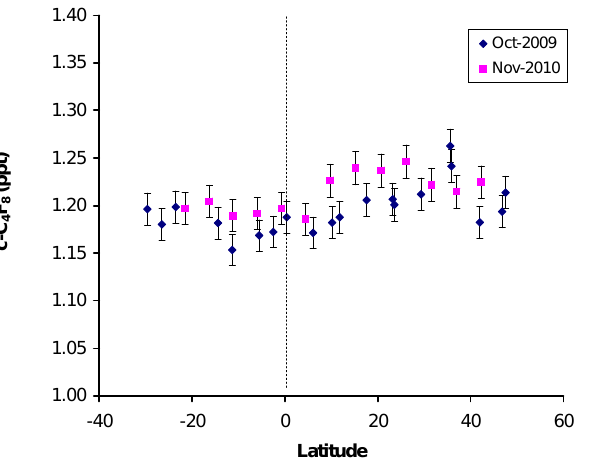
Fig. 4. Lower stratospheric measurements of c-C 4 F 8 from Geo- physica flights in the Northern Hemisphere between October 2009 and January 2010 plotted against mean age of air. y-axis error bars show the mean analytical precision (1 σ) and the x-axis errors bars represent the mean (1 σ) uncertainty in the age calculation from measured SF 6